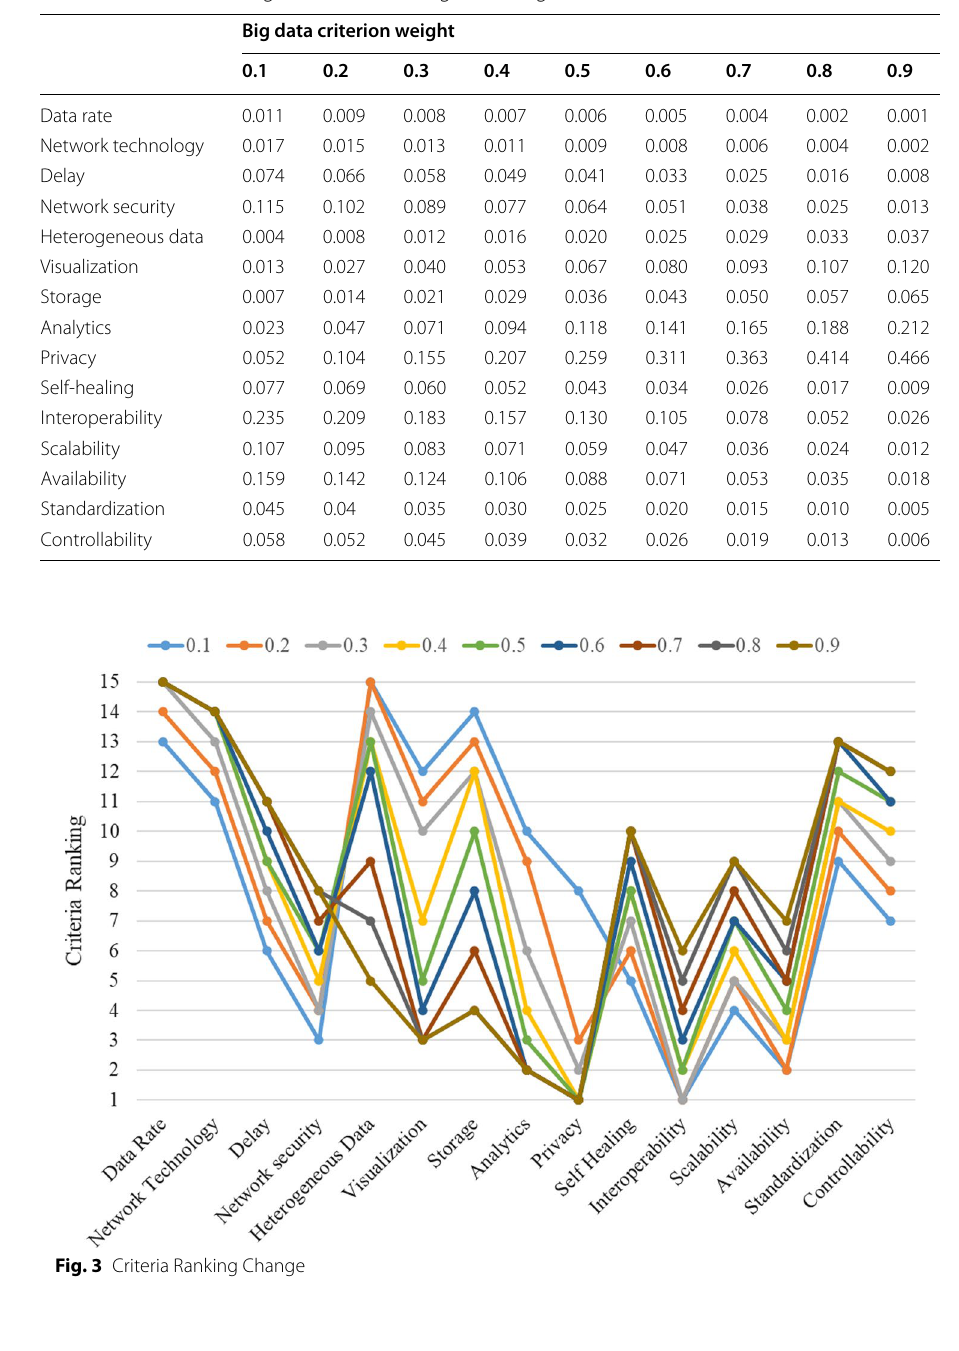
Table 3 Sub-criteria weights with various ‘Big Data’ weights from 0.1 to 0.9